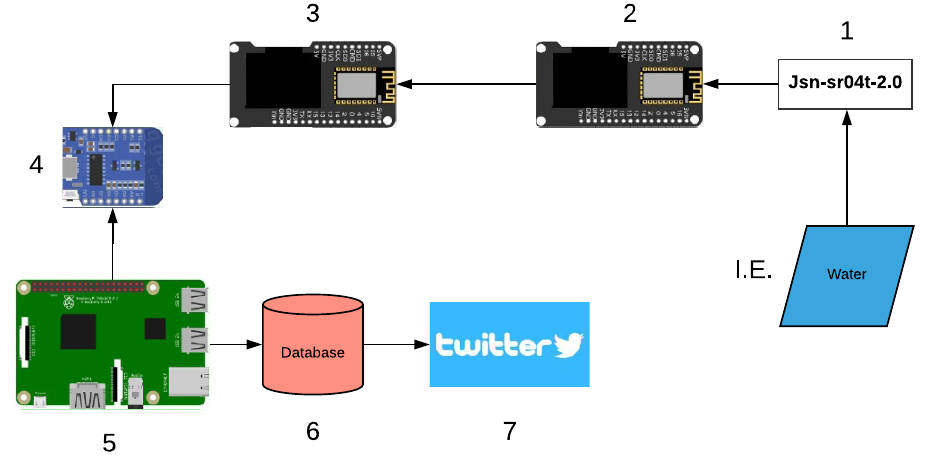
Figure 1. System architecture raised.